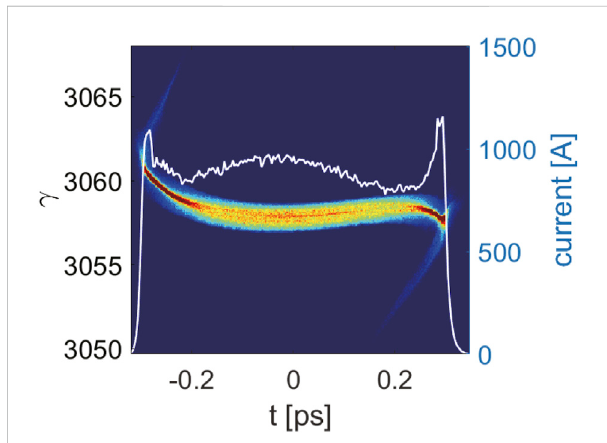
FIGURE 5 Longitudinal phase spaceand current distribution oftheelectron beam by the end of the LINAC of the SXFEL-UF.